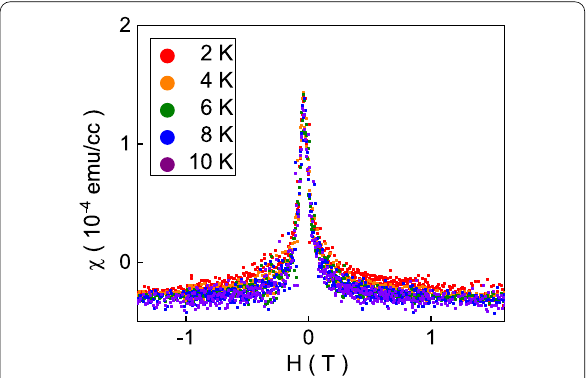
Fig. 4 The susceptibility as a function of magnetic fields from 2 to 10 K. All data collapse onto a single